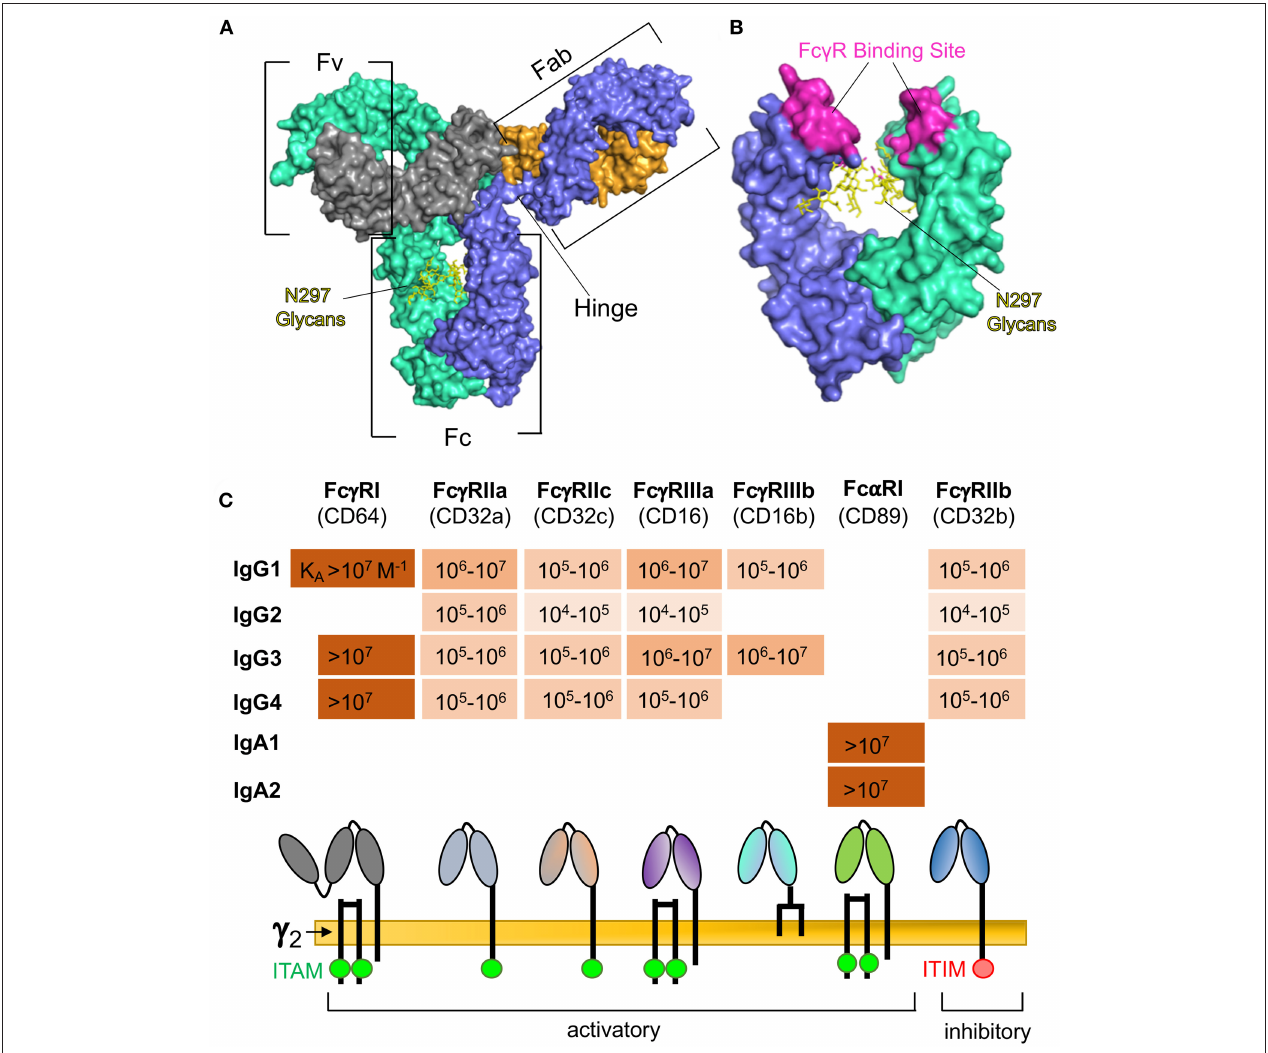
FIGURE 1 | (A) Surface representation of human IgG1 indicating: the Fv regions, which are the portions of the Fab arms required for antigen binding; the Fc region, which interacts with immunoproteins and specific receptors for effector functions; and the hinge region, which provides flexibility for the Fab and Fc regions. The IgG heavy chain 1 is depicted in blue, heavy chain 2 in teal, light chain 1 in orange, and light chain 2 in gray. Glycans are represented by yellow sticks. Rendering was made in PyMOL software using protein data bank ID 1HZH. (B) Expanded view of human IgG1 Fc region after 180 ◦ rotation, indicating residues involved in binding to Fc γ receptors (2–5), and the glycosylation site at asparagine 297 (N297). (C) Binding affinities (6–8) of Fc receptors commonly implicated in ADCP and comparison of receptor composition and signaling domains. Absence of values indicates no detectable